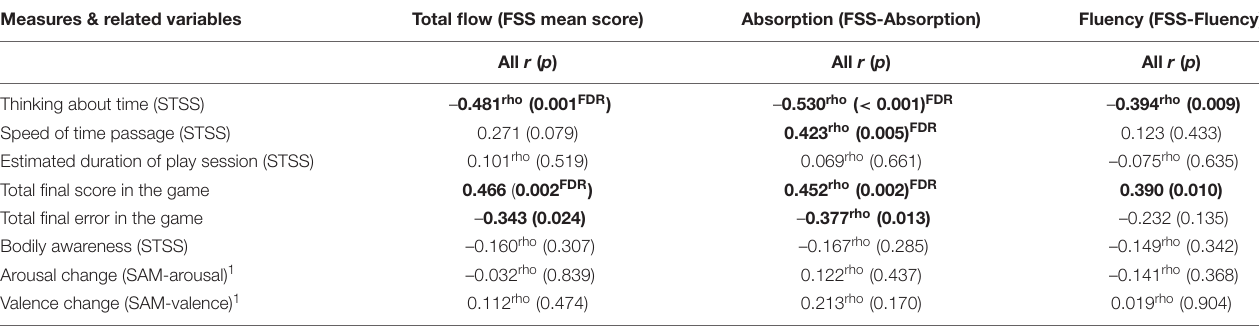
TABLE 1 | Correlation coefficients and related p -Values between the total flow, absorption, and fluency subscales of flow and related variables for all